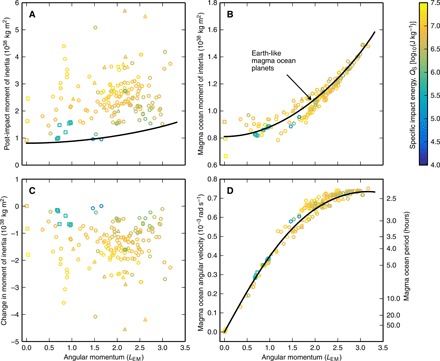
The moments of inertia of condensed magma ocean planets are lower, and their rotation rates are faster than those of post-impact bodies.(A) The moments of inertia of the same post-impact bodies as shown in Fig. 2. (B) Moments of inertia of magma ocean planets with the same mass, composition, and AM. (C) Change in the moments of inertia due to condensation of the silicate vapor. (D) Angular velocity of magma ocean planets with the same mass, composition, and AM. Colors and symbols are the same as in Fig. 2. Black lines show the moment of inertia (A and B) or angular velocity (D) of an Earth-like, magma ocean planet as a function of AM. Note the large change in vertical scale between (A) and (B).